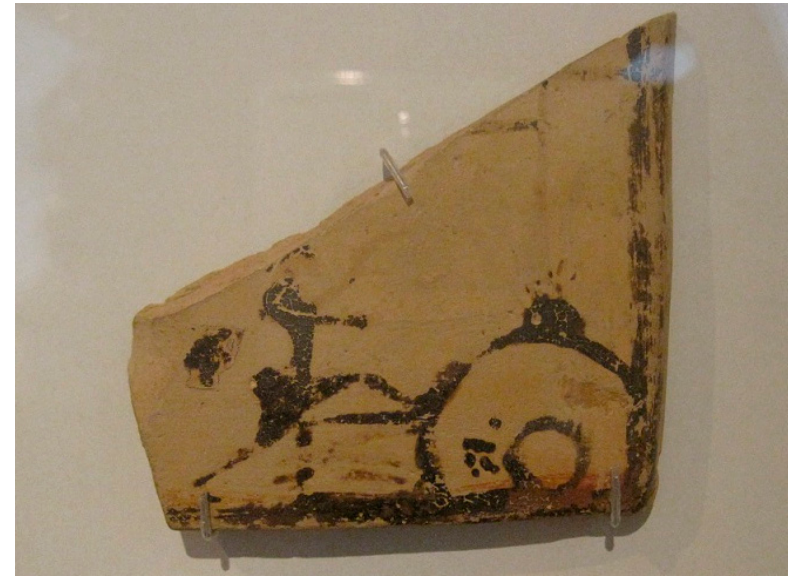
Figure 11. Pinax, Penteskouphia, Corinth, 575–550 BCE, Berlin, Staatliche Museen, F616. Author’s own image.